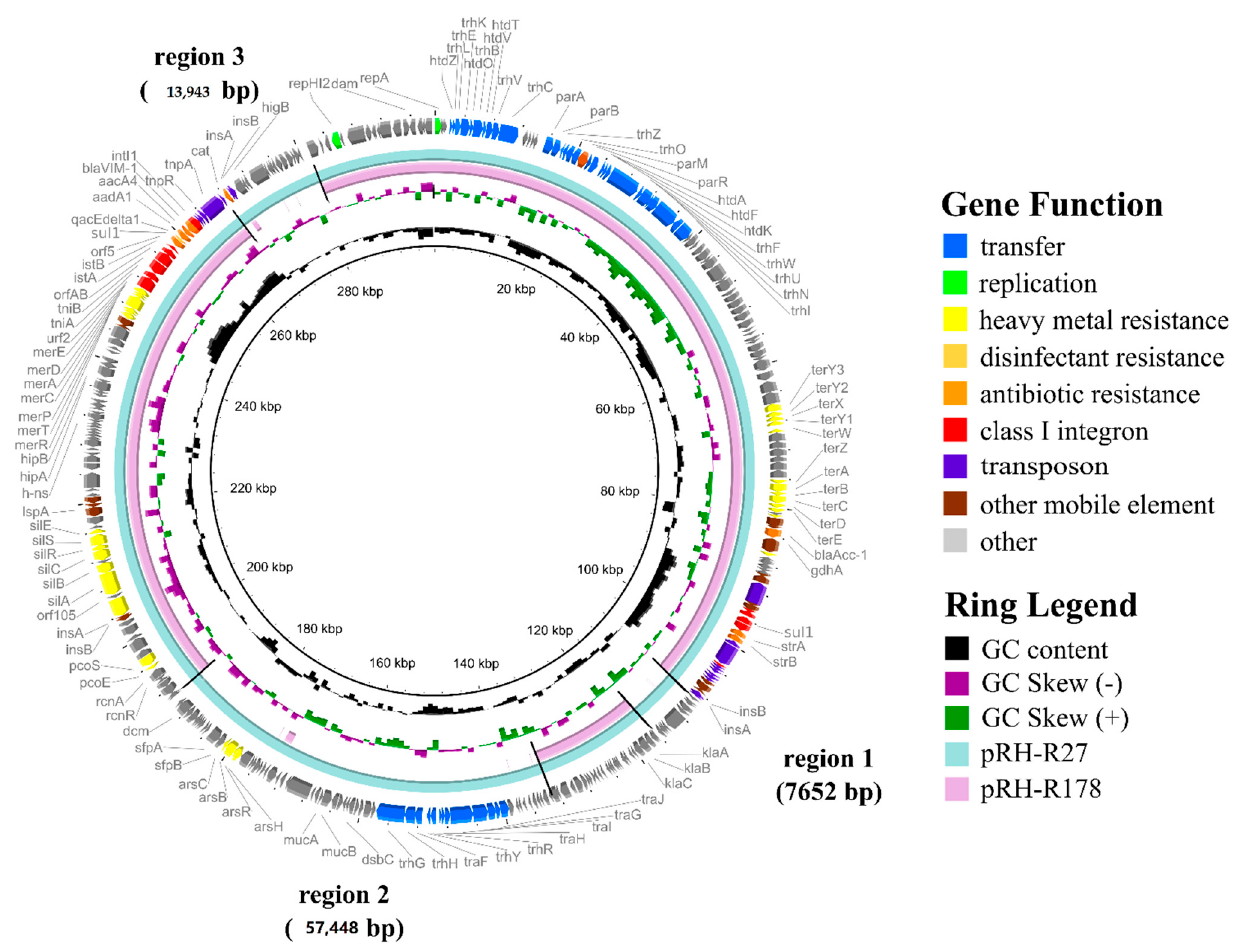
Figure 1. Comparative plasmid maps of pRH-R27 from Salmonella enterica and pRH-R178 from Escherichia coli . Deleted regions (1–3) are indicated on the map and pRH-R27 was used as reference. All sequences show >95% DNA sequence identity. Coloured regions represent functions and features indicated in the figure legend. The IncHI2 plasmid harbored by S. Infantis (pRH-R27) isolated from a livestock farm in Germany carries antibiotic resistance genes ( blaVIM-1 , aacA4 , aadA1 , sul1 , blaACC-1 , strA/strB , and catA1 ), disinfectant resistance ( qacE Δ 1 ) and heavy metal resistance ( ter- , mer- , sil- , ars- , rcn- , and pco ). The figure was reproduced with permission from [47].